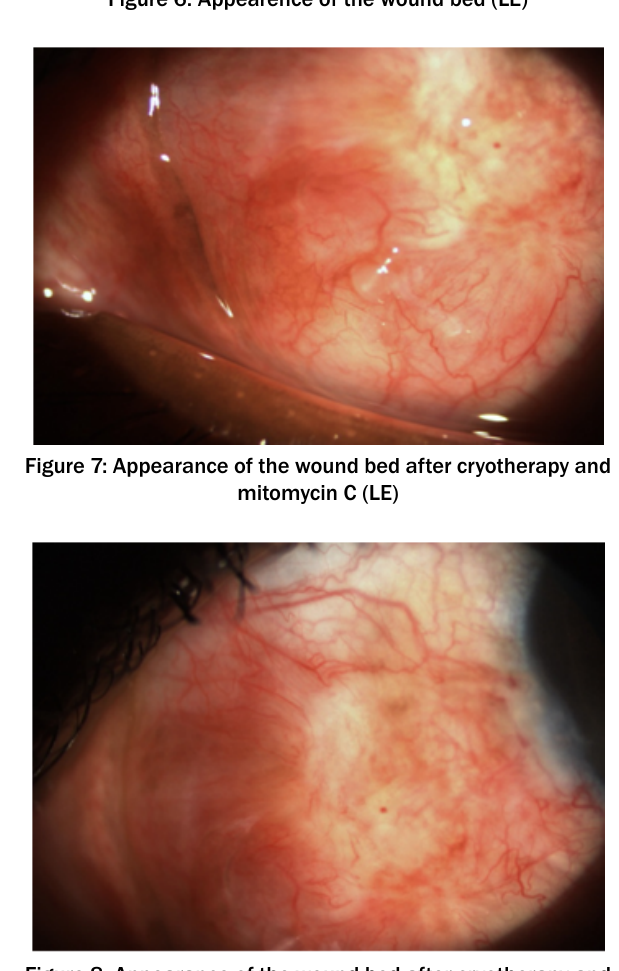
Figure 8: Appearance of the wound bed after cryotherapy and mitomycin C